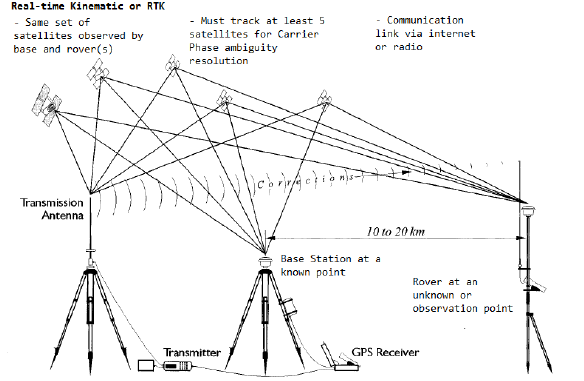
Figure 6. Diagram of typical GNSS set-up for RTK observations. Adapted from Van Sickle